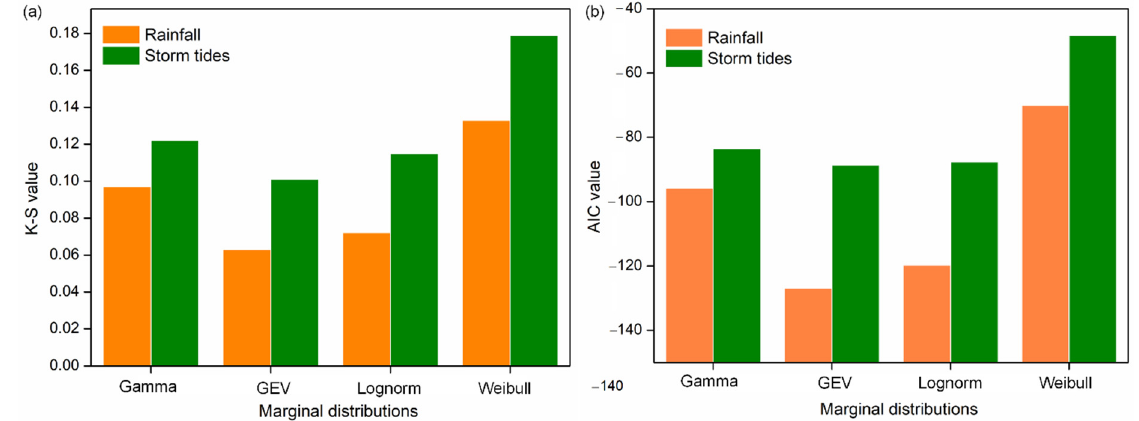
Figure 4. The ( a ) K–S and ( b ) AIC values of four marginal distributions.